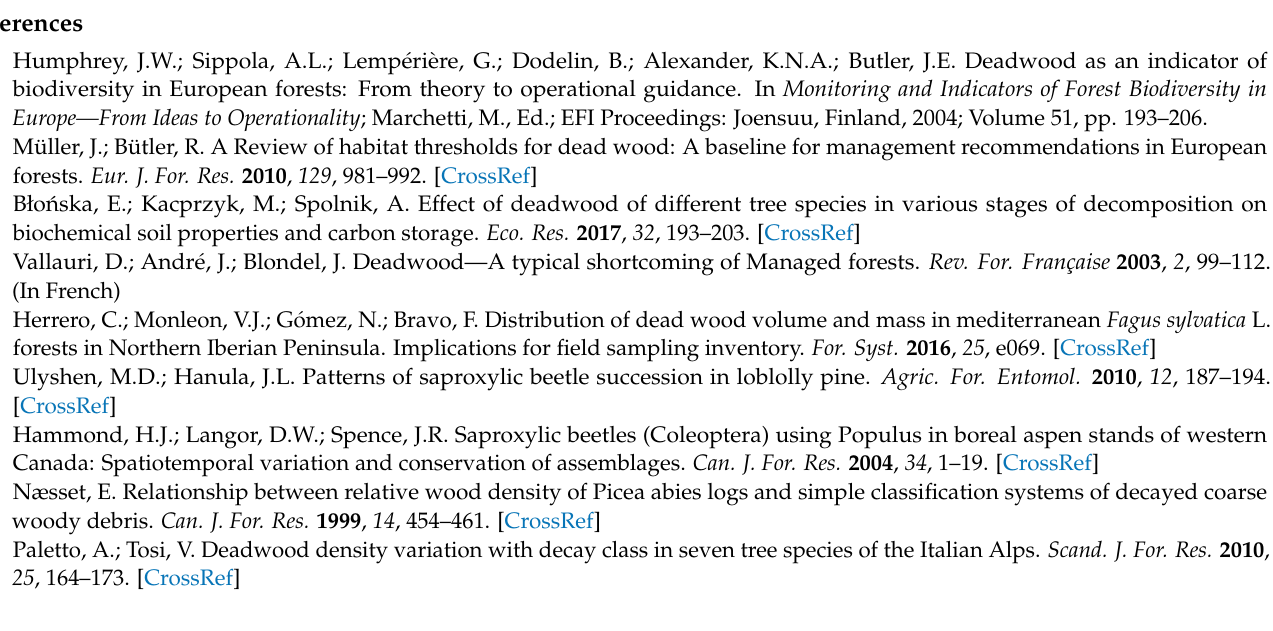
Table S2: Primer pairs used for real time PCR absolute quantification of the different microbial groups assessed in the five deadwood decay classes. Table S3: Maximum values of CO 2, CH 4 , and N 2 O production from black pine deadwood cores under laboratory experiment. Mean values according to each decay classes are also reported (standard errors in parentheses). Different letters in a column indicate significant differences at p < 0.05 (LSD test) among means. Table S4: ANOSIM and PERMANOVA global test based on the Bray–Curtis similarity matrices of 18S- and 16S-rDNA DGGE, for microbial groups (fungi, bacteria, and actinobacteria) decaying downy birch deadwood. Table S5: Values of ANOSIM statistic R (upper right side) and PERMANOVA statistic F (lower left side) from pairwise comparison of the banding profiles of fungal 18S-rDNA DGGE, and bacterial and actinobacterial 16S-rDNA DGGEs. Figure S1: Maximum values of CH 4 production (a) and archaeal methanogen 16S rDNA gene copies number (b) from each black pine deadwood sample. Figure S2: Maximum values of N 2 O production (a) and nir K gene (b) and nos Z gene (c) copies number (botton) from each black pine deadwood sample. Figure S3: DGGE profiles of fungal 18S rDNA gene fragments (a), bacterial 16S rDNA gene fragments (b), and actinobacterial 16S rDNA gene fragments (c). The letter M on the gel images indicates the marker used for normalization of